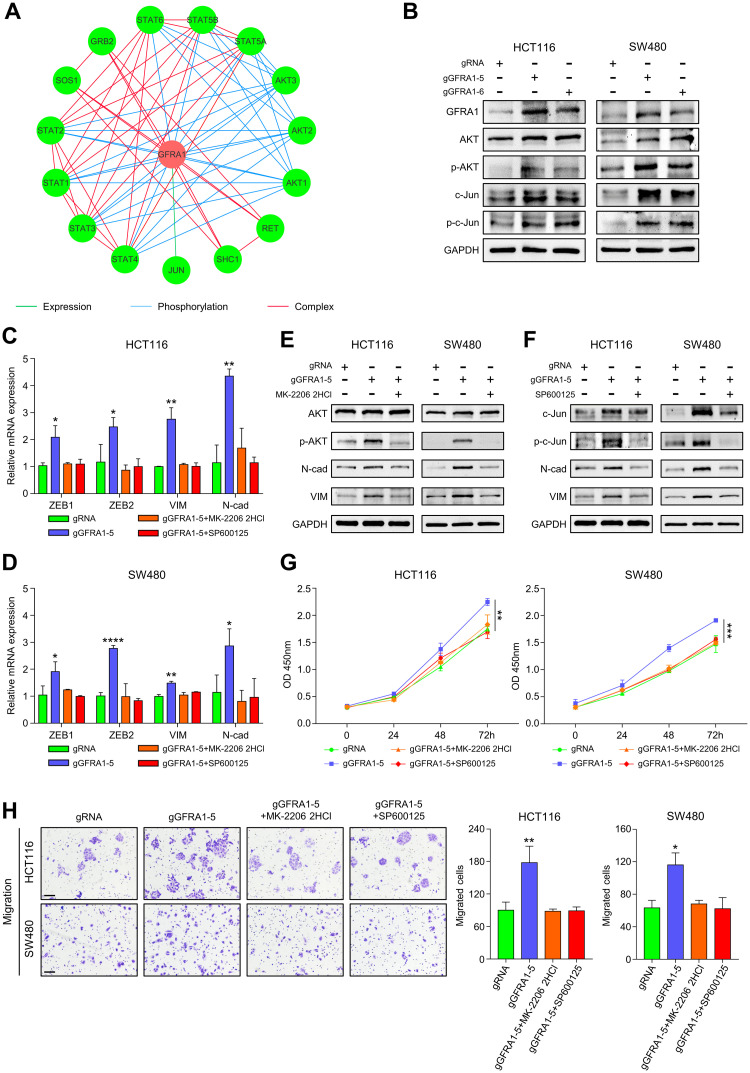
Hypomethylation of GFRA1 leads to EMT being blocked by p-AKT and p-C-Jun inhibitors.A Pathway Common network conducted by GFRA1 related genes. The nodes represent genes, edges display an interaction between query genes (Green line: control expression; Blue line: control Phosphorylation; Red line: in complex). B Western blot analyses display the effects of GFRA1 hypomethylation on the protein expression of AKT, p-AKT, c-Jun, and p-c-Jun in HCT116 and SW480 cells. C-D The mRNA expression levels of ZEB1, ZEB2, VIM, and N-cad in GFRA1 hypomethylation CRC cells treated with MK-2206 2HCl and SP600125 or DMSO, were detected by q-PCR (*p < 0.05, **p < 0.01, ****p < 0.0001; Student’s t-test). E-F Western blot analyses showing the protein expression of AKT, p-AKT, c-Jun, and p-c-Jun in HCT116-gGFRA1-5 and SW480-gGFRA1-5 cells treated with MK-2206 2HCl (E) and SP600125(F) or DMSO. G CCK8 experiment demonstrates the effect of treatment with MK-2206 2HCl and SP600125 on cell proliferation in GFRA1 targeted demethylation cells (**p < 0.01, ***p < 0.001; Student’s t-test). H Effects of MK-2206 2HCl and SP600125 treatment on cell migration in GFRA1 hypomethylation CRC cells, as evaluated by Transwell assays. (*p < 0.05, **p < 0.01; Student’s t-test), and the data are mean ± SD from at least three independent experiments. Scale bars represent 100 μm.